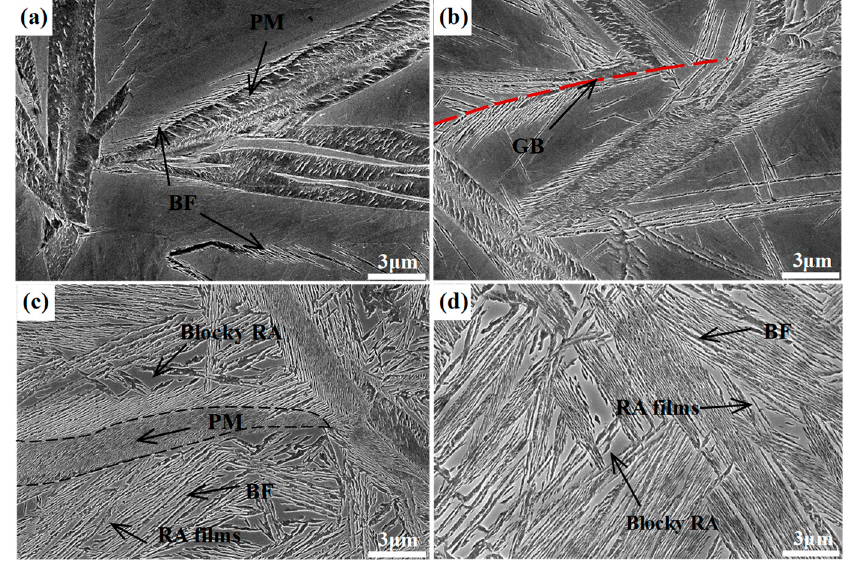
Figure 4. SEM micrographs of different samples after isothermal treatment at 300 °C for different times. ( a – c ) are the QBT-12 sample austempering for 1 min, 5 min, and 4 h, respectively; ( d ) is the DIT sample austempering for 4 h. RA films refer to film-like retained austenite, Blocky RA to blocky retained austenite, GB to grain boundary, and PM to prior martensite.